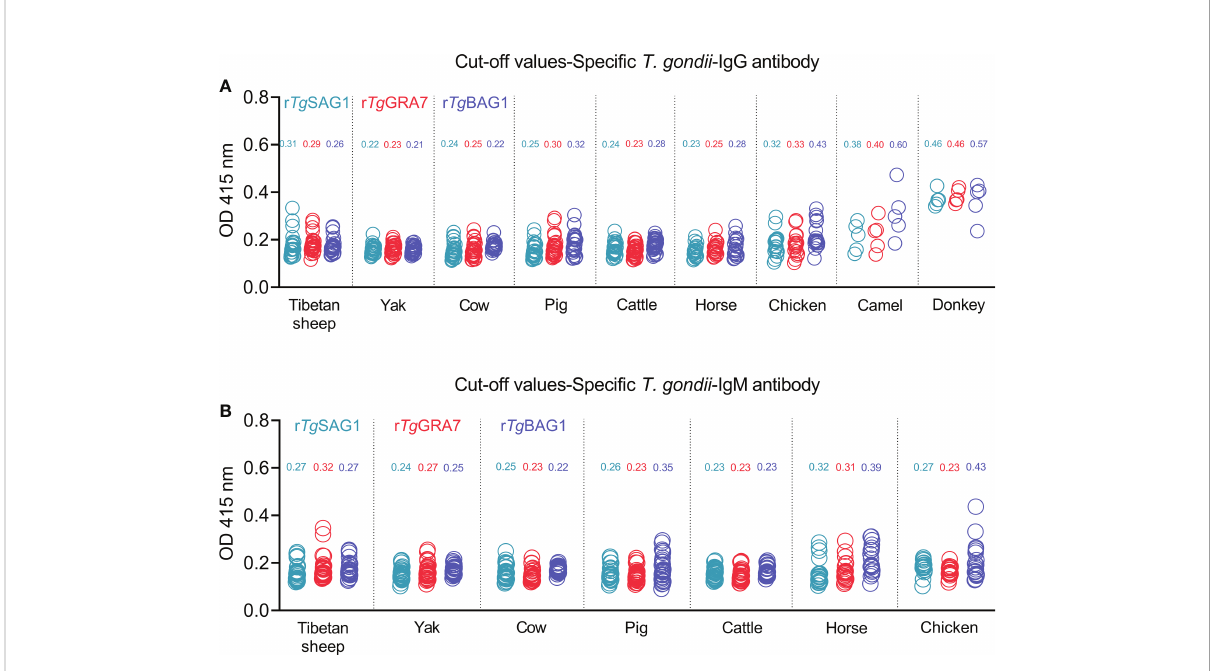
FIGURE 2 Establishment of rSAG1-ELISA, rGRA7-ELISA and rBAG1-ELISA tests and calculating the cut-off values for T. gondii IgG (A) and IgM (B) antibodies.